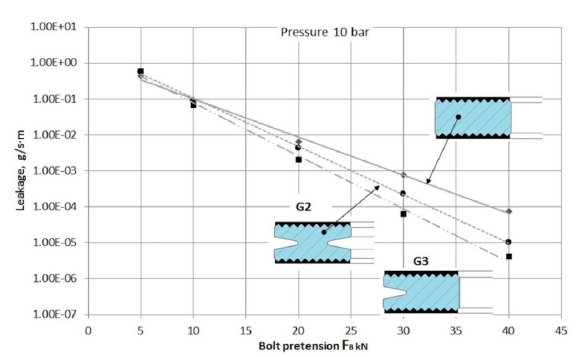
Figure 5: Tightness characteristic obtained at loading